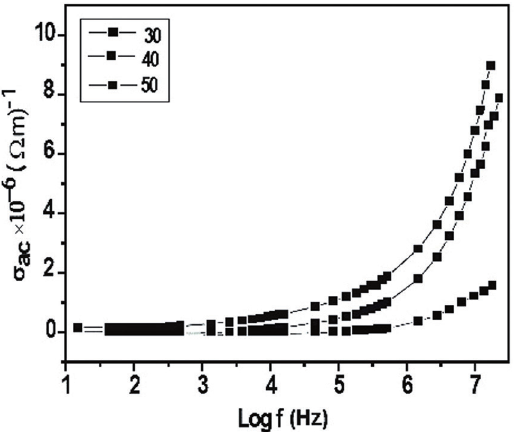
Figure 7: Variation of ac conductivity with frequency at various temperatures.